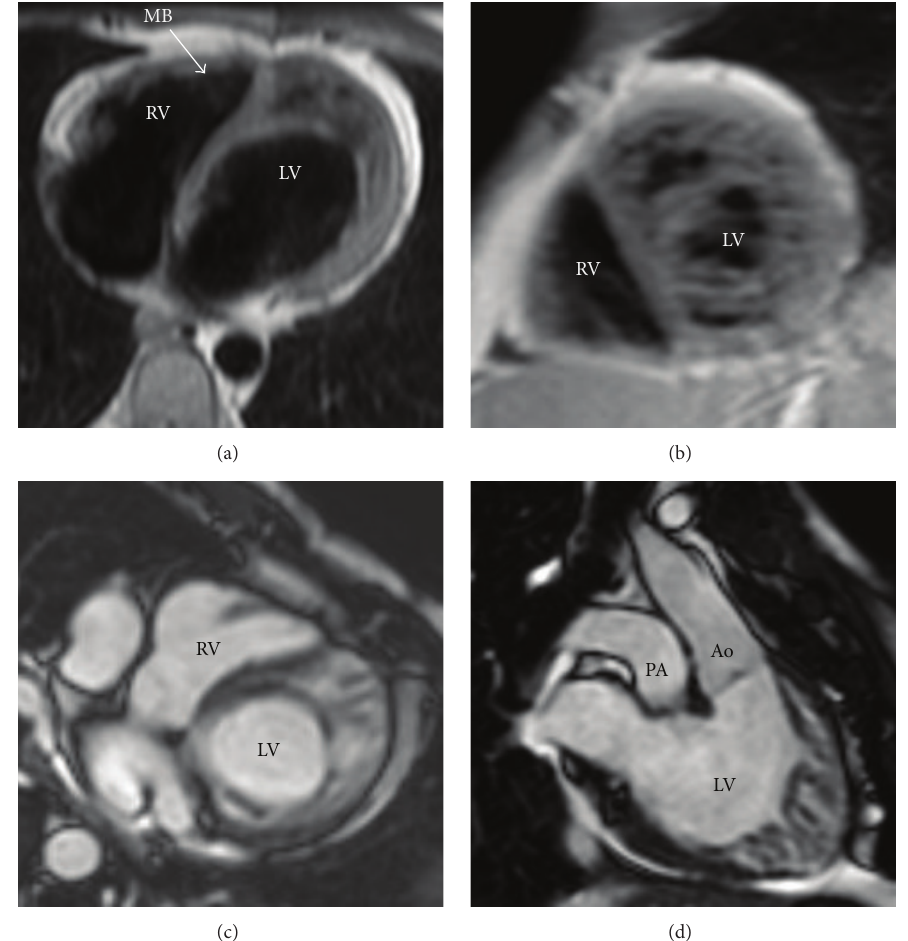
Figure 3: Cardiac MRI long axis (a) and short axis (b) black blood fast spin echo images of LV, with end-diastolic long axis ((c), (d)) cine balanced steady-state free precession acquisition, confirming the presence of the anatomic features of NC in the mid and apical segments. MB moderator band